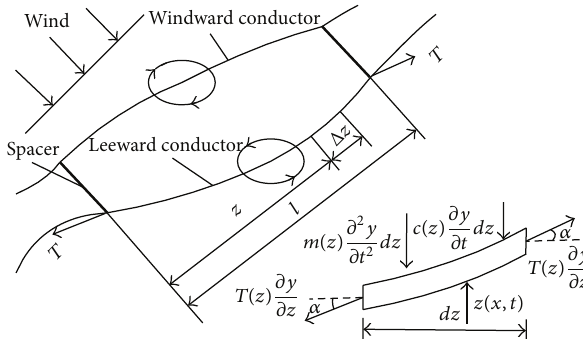
Figure 6: Mechanical model of the twin bundled